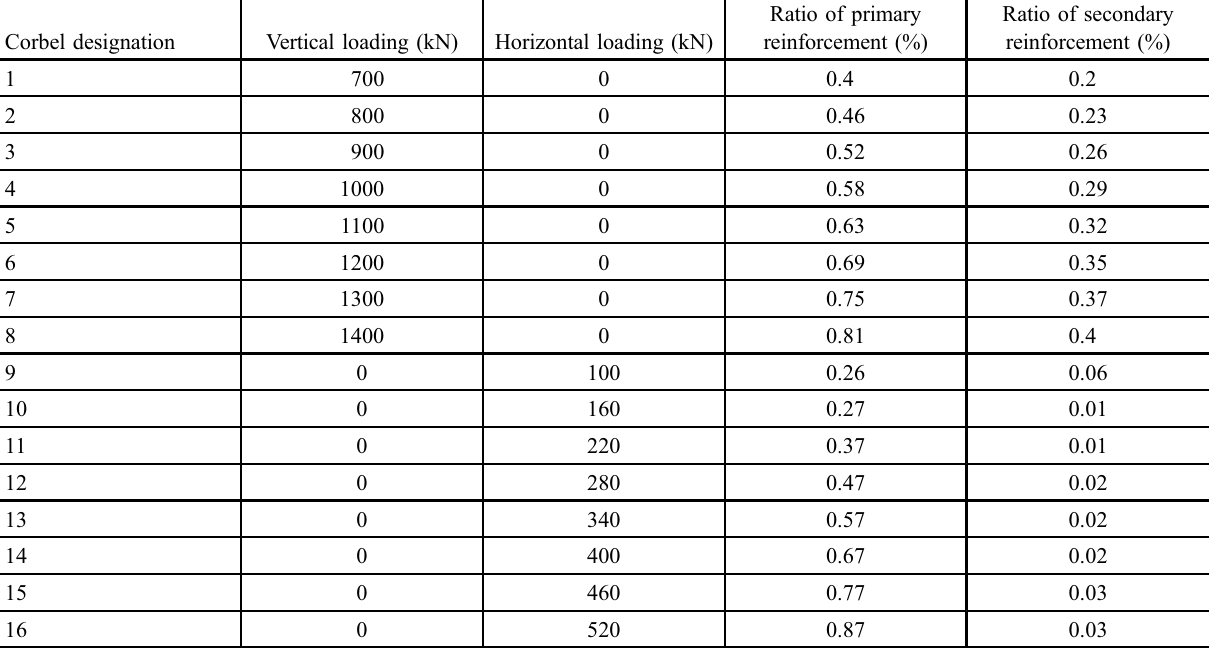
Table 6. Details of reinforcements in corbels designed as per PCI equations